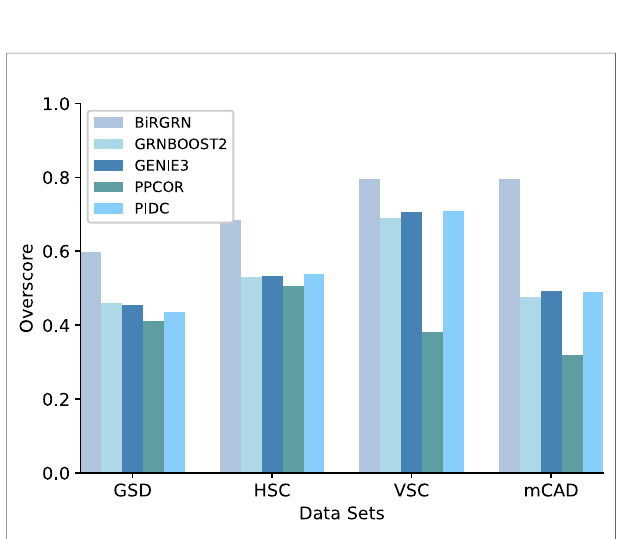
FIGURE 5 | The overall score of the algorithm on the four simulated